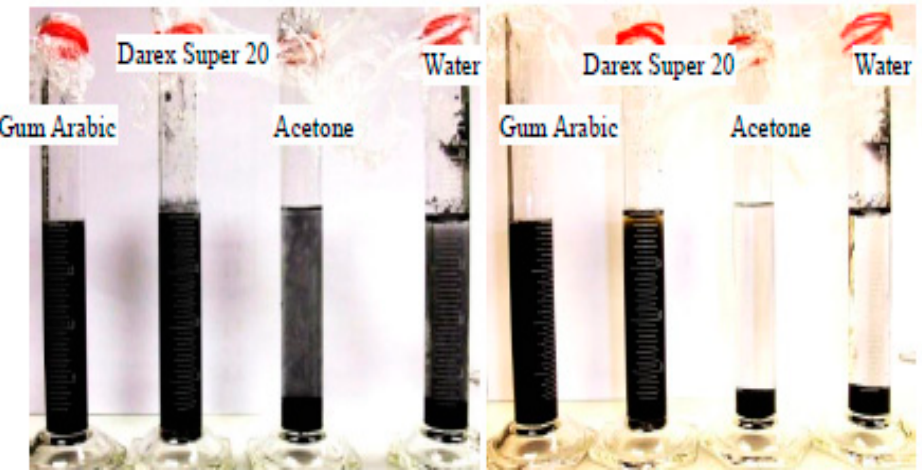
Figure 4. Stability test for graphite suspension in various dispersant of liquid at 5 min (left) and 30 min (right). Reproduced with permission from [79], ME. Thesis, National University of Singapore, 2012.